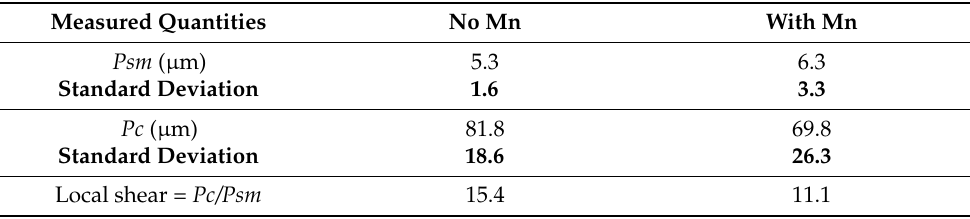
Table 5. Local shear is estimated from the experimental measurements.